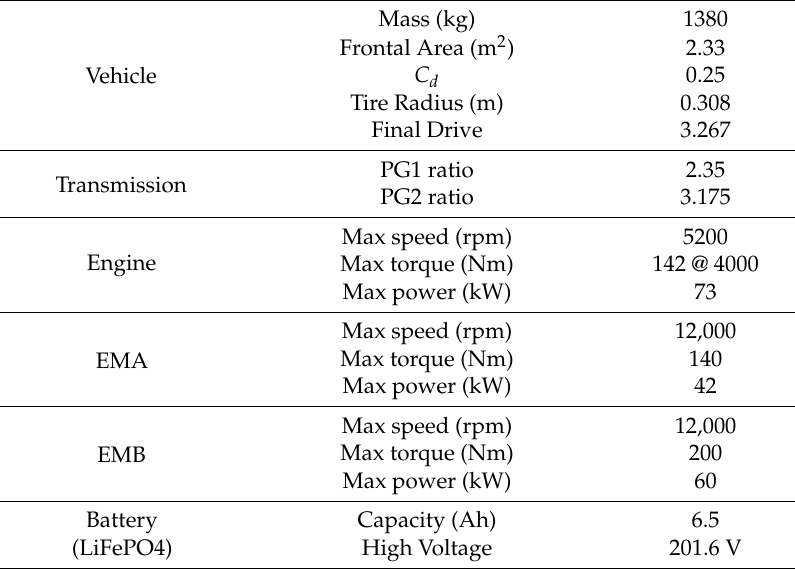
Table A1. Vehicle